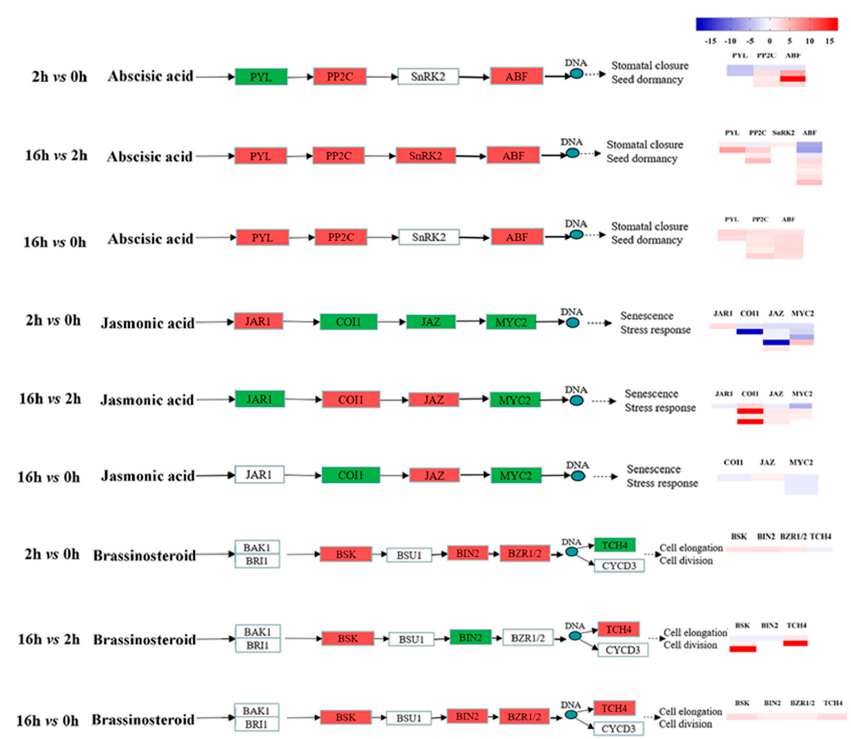
Figure 7. Plots showing the effects of drought stress on plant hormone synthesis in Kentucky Bluegrass. ( A ) Leaf hormone contents at 0, 2, and 16 h after drought stress, ( B ) DEGs predicted to be involved in “Abscisic acid biosynthesis”, ( C ) DEGs predicted to be involved in “Jasmonic acid biosynthesis”, ( D ) DEGs predicted to be involved in “Brassinosteroid biosynthesis”. In panel B , C , and D , red color represents up-regulated genes, green color represents down-regulated genes, white color represents unchanged genes.